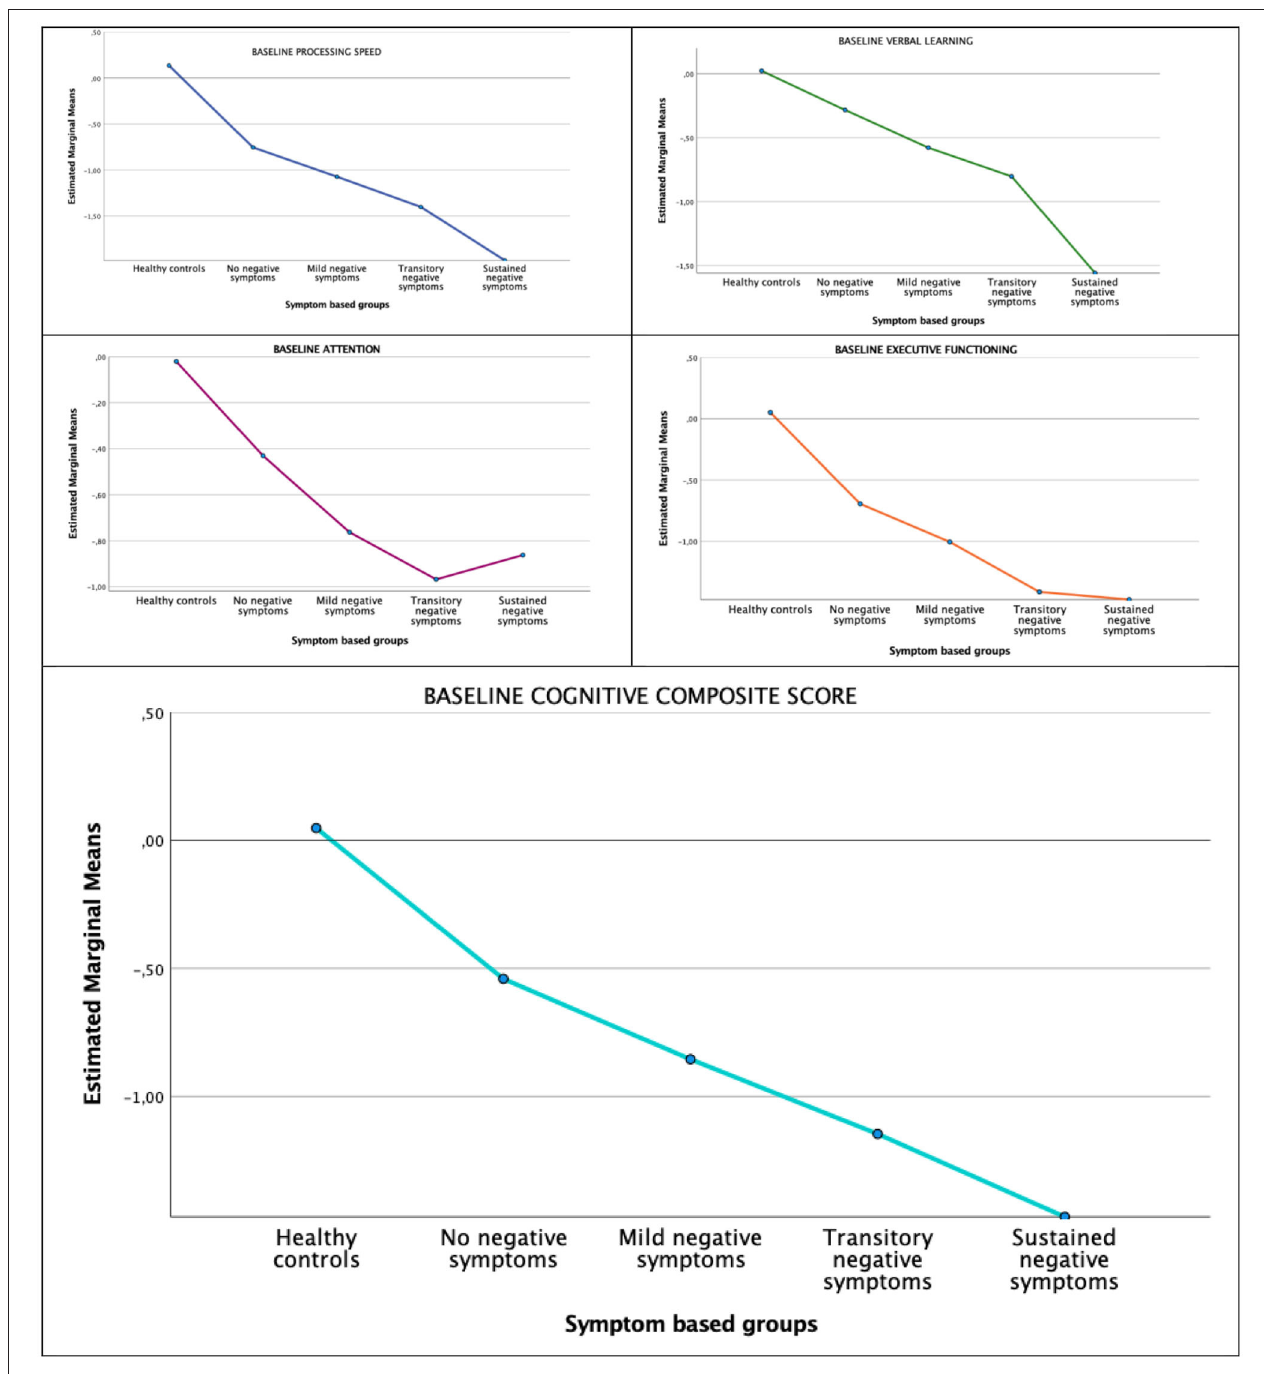
FIGURE 2 | Cognitive domains by negative symptom groups at